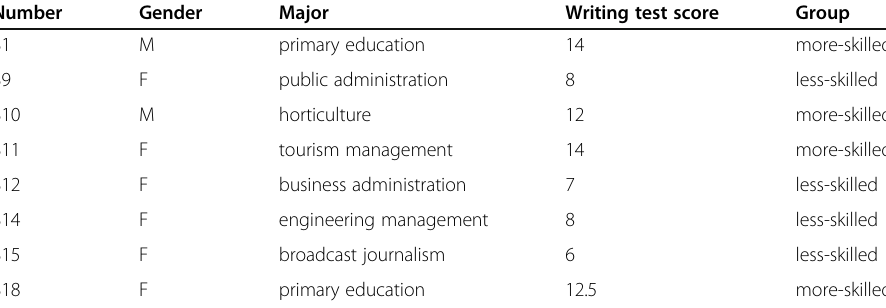
Table 1 Characteristics of the student participants in the case